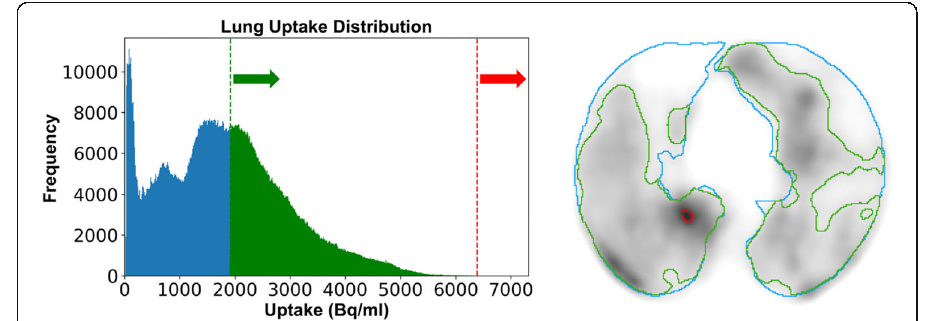
Fig. 1 Example of functional volume delineation in the presence of an airway artifact. Whole lung volume is shown in blue. The aggregated, non-physiological uptake (red) is detected by histogram analysis, and a more representative peak uptake value is designated. The resultant functional volume from 30% threshold is shown in